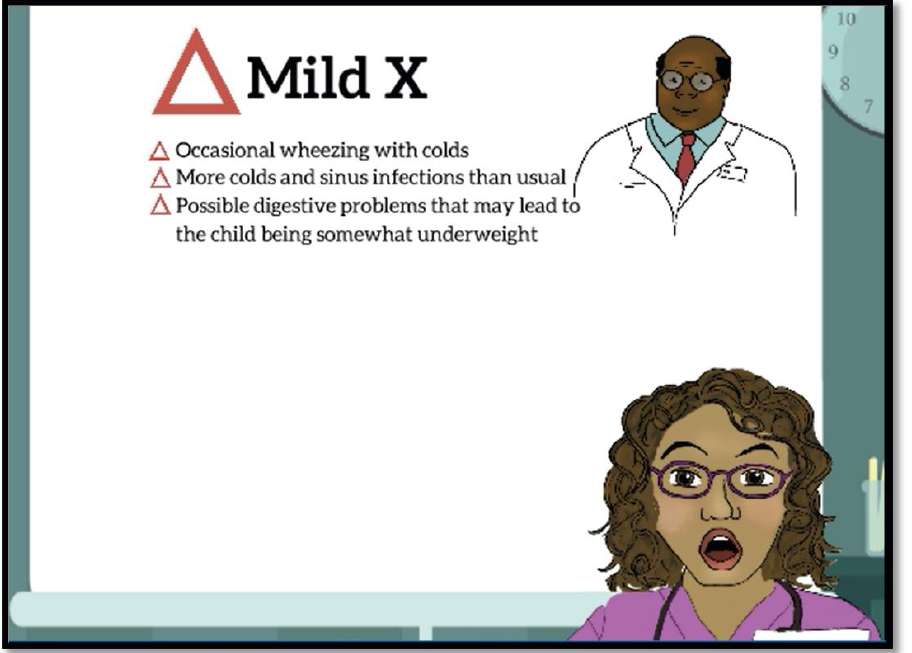
Figure 2. Still Image from the second video depicting symptoms of “Mild X” (analogous to CRMS/CFSPID). Full video available at https://www.youtube.com/watch?v=3HiFPywnCb0 [last accessed on 25 July 2022].